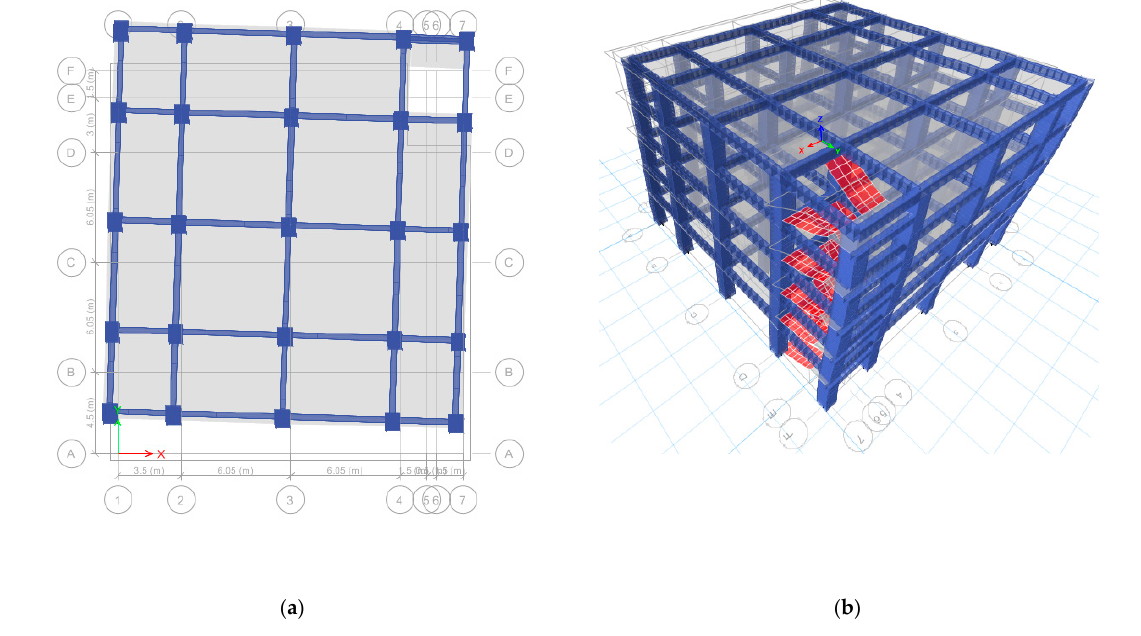
Figure 13. The 1st mode shape for T 1 = 0.385 s: ( a ) plane view, and ( b ) 3D view.